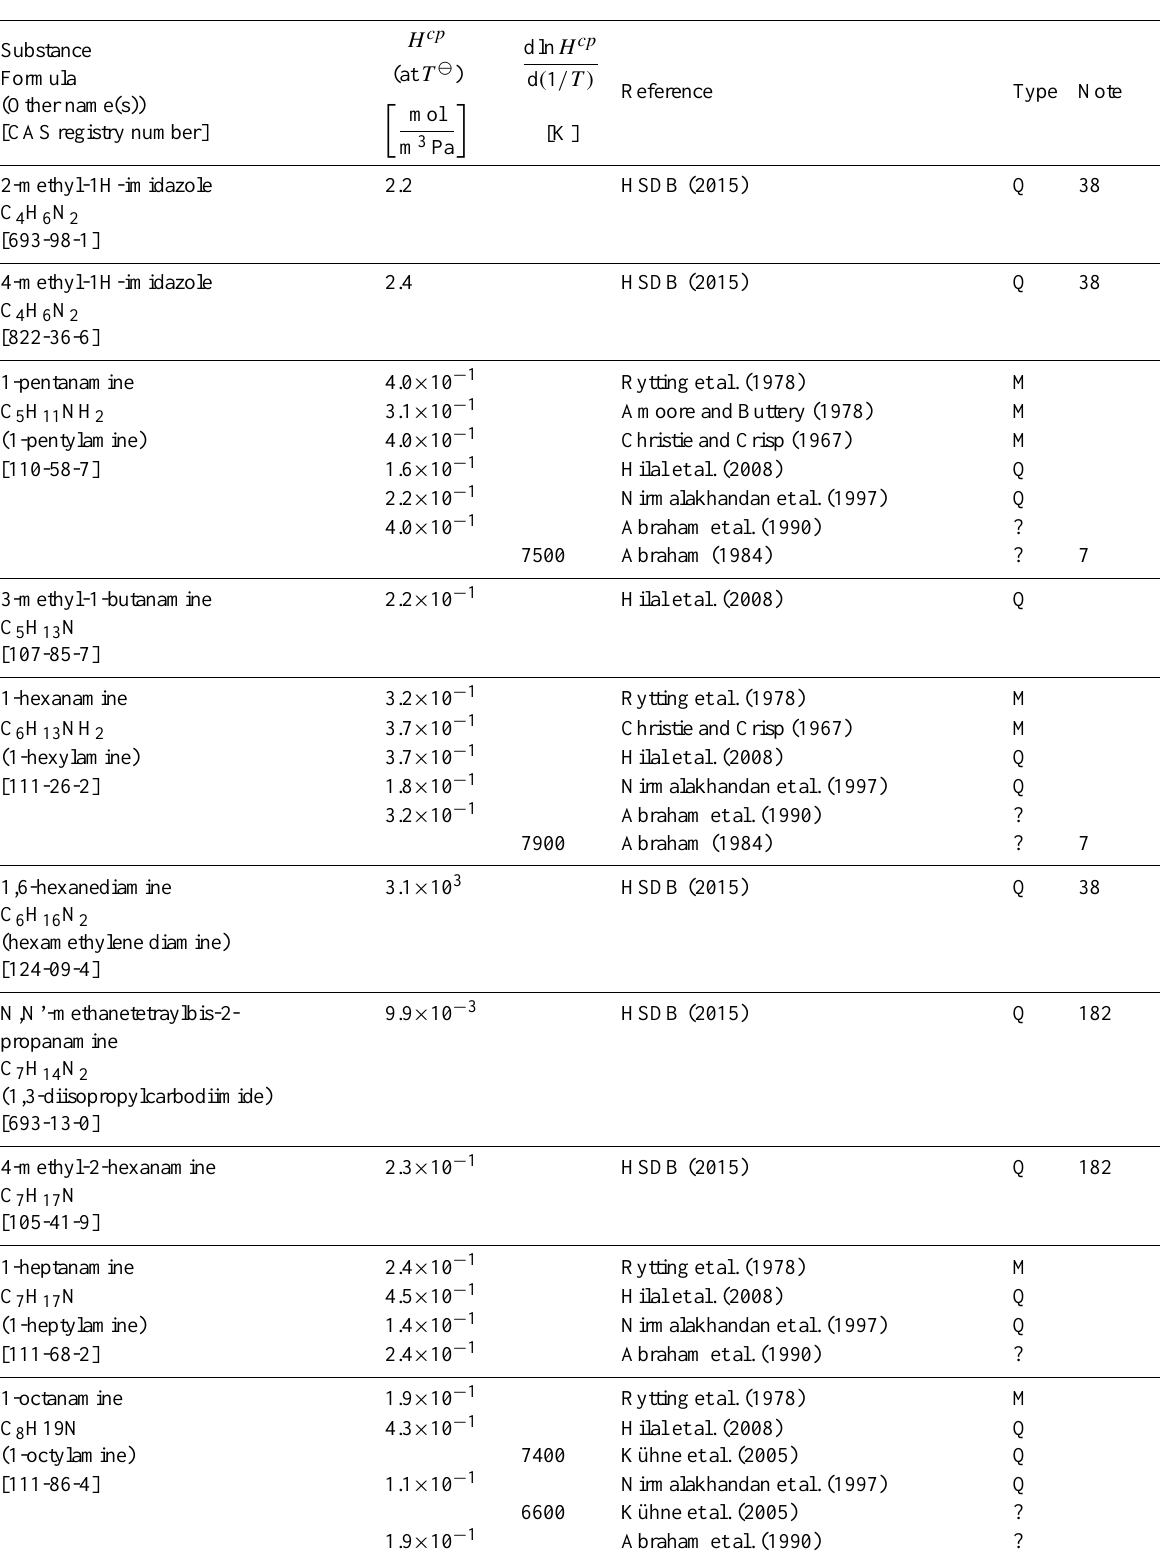
Table 6: Henry’s law constants for water as solvent